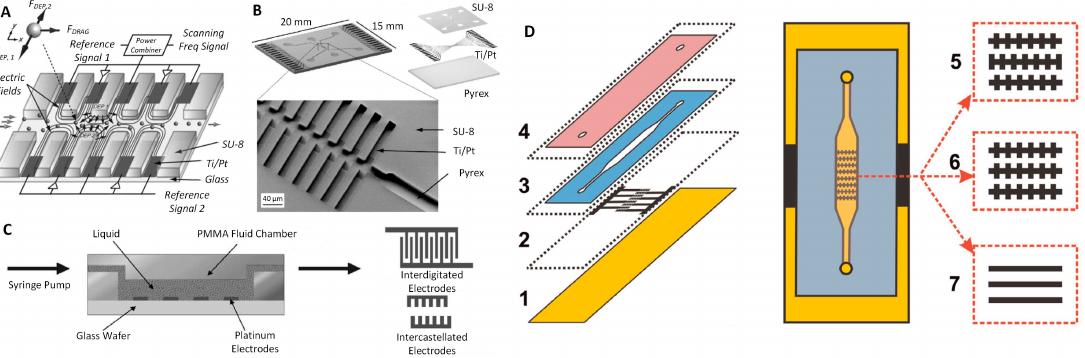
Figure 6. Devices with castellated electrodes. ( A ) Schematic of an insulator and 2D electrode device to focus and separate particles by applying different frequencies and amplitudes of an AC power supply [70]. ( B ) 3D drawing and scanning electronic microscopy image of the device. Reproduced with permission from [70], © 2008 Elsevier. ( C ) Schematic of the combined interdigitated and castellated electrode device. It was used to quantitatively evaluate the particle and cell separation. Reproduced with permission from [71], © 2003 Elsevier. ( D ) Schematic of a device based on screen-printing fabrication. Reproduced with permission from [63], © 2015 Elsevier.